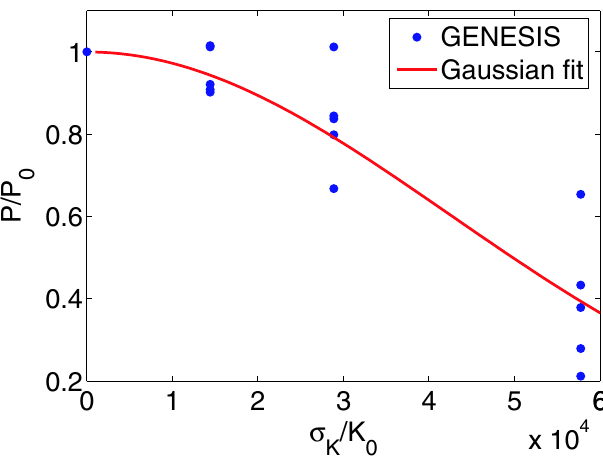
FIG. 13. (Color) Power degradation factor P=P =K in the LCLS 33 undulator segments. Here, (cid:6) tion versus (cid:6) K 0 is the rms value of a uniform segment K error distribution. Five random error distributions are used for a given (cid:6) width of the Gaussian fit is 4 : 2 (cid:9) 10 (cid:7) 4